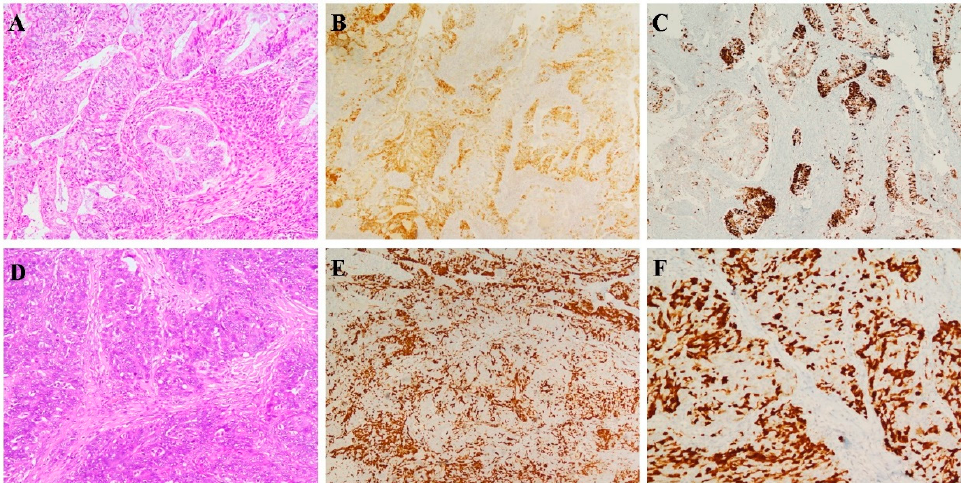
Figure 2. p16 INK4a comparative immunostains with E6H4 and BC42 clone tumors. ( A ) Moderately differentiated endometrioid endometrial adenocarcinoma showing a similar focal/patchy staining pattern for p16 with E6H4 ( B ) and BC42 ( C ) clones. ( D ) High-grade ovarian serous carcinoma demonstrating similar distribution and staining intensity with both E6H4 (E) and BC42 ( F ) clones.